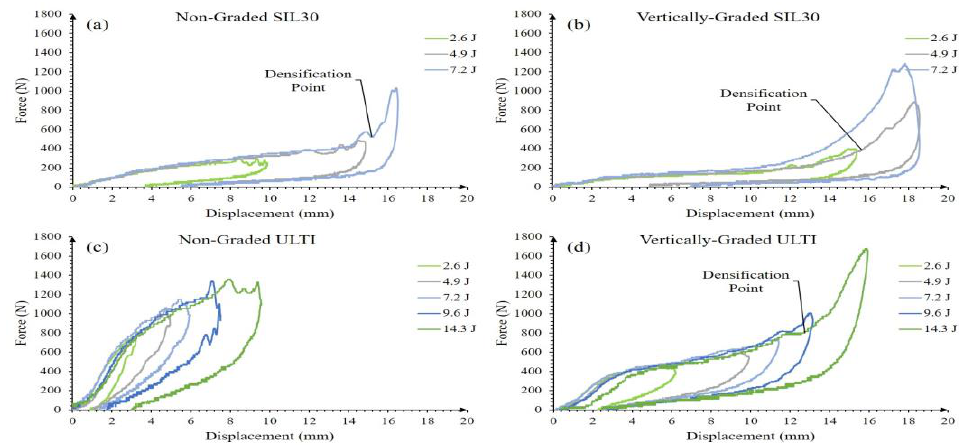
9 of 20 Figure 4. Force versus time of SIL30 and ULTI at different impact energies; ( a ) SIL30-NG (non- graded), ( b ) SIL30-VG (vertically-graded), ( c ) ULTI-NG, and ( d ) ULTI-VG with peak force values labeled for comparison. Figure 5 shows the force-displacement response of the SIL30 and ULTI materials based on the uniform- and vertically-graded configurations. The SIL30 displayed an in- herently compliant elastomeric profile with a relatively low stiffness, providing improved comfort for wearables (i.e., football helmets) but rendering the material not well suited for high energy impacts due to immediate densification. By comparing the energies imparted to the lattices, it can be observed that the NG system displays a lower displacement than the vertically-graded lattices. For instance, the SIL30-NG non-graded structure was sub- jected to 2.6 joules and deformed by approximately 10 mm, while the vertically-graded counterpart reached 15 mm. Similarly, the ULTI-VG vertically-graded system shows a